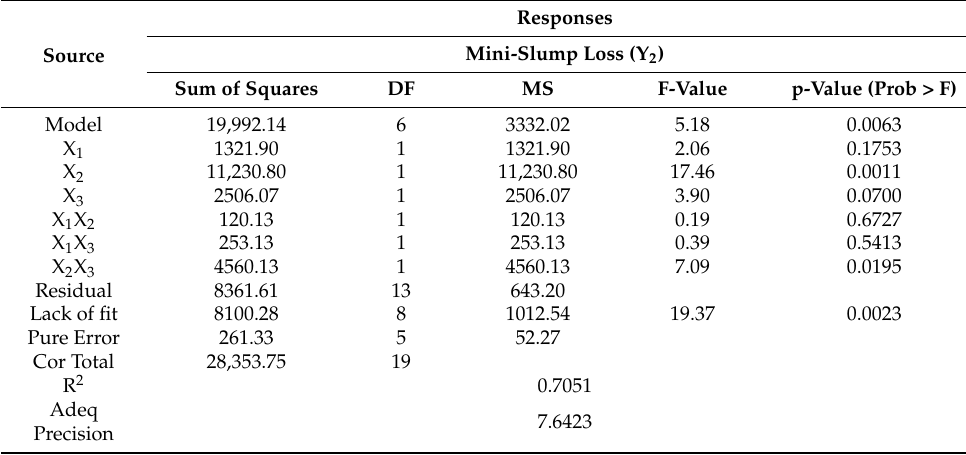
Table 6. Analysis of variance (ANOVA) of the response model of mini-slump